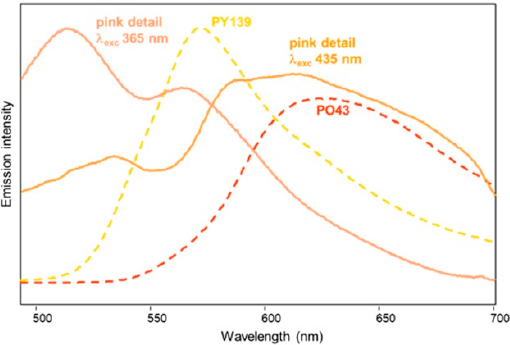
Figure 12. Emission spectra of the pink hue of the clouds in the painting “Addetta near Zoate” by G. Faraone with excitation at 365 and 435 nm (solid lines), and of painting samples of PY139 and PO43 with linseed oil (dashed lines) shown for comparison.